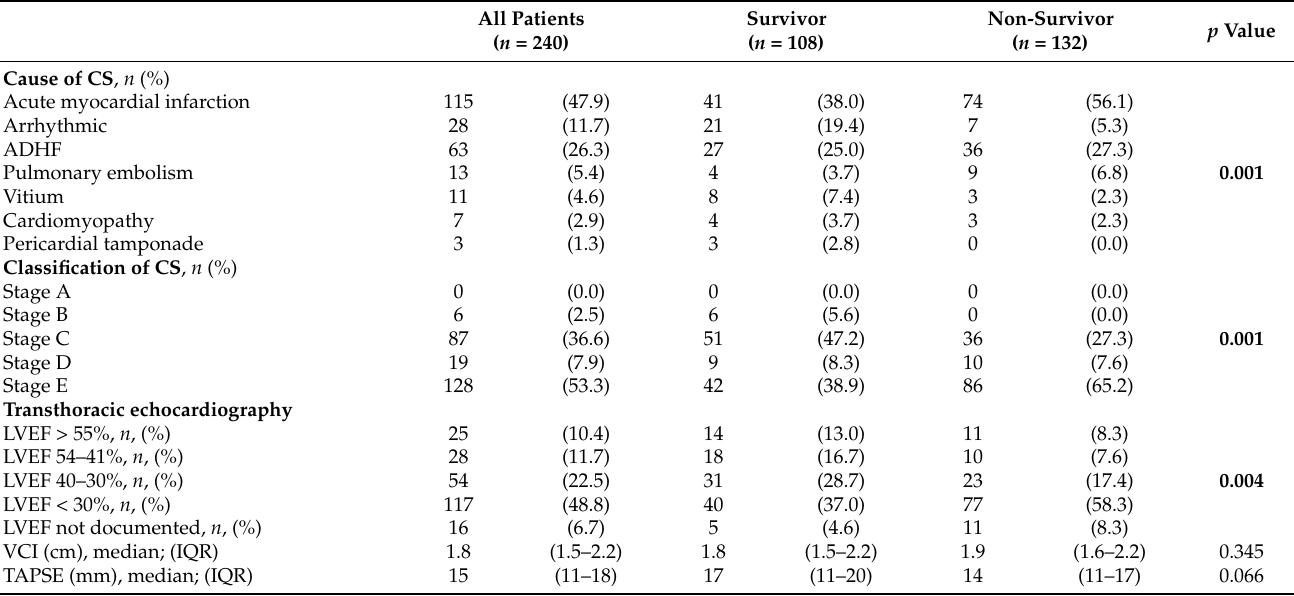
Table 2. Shock-related data, follow-up data, and